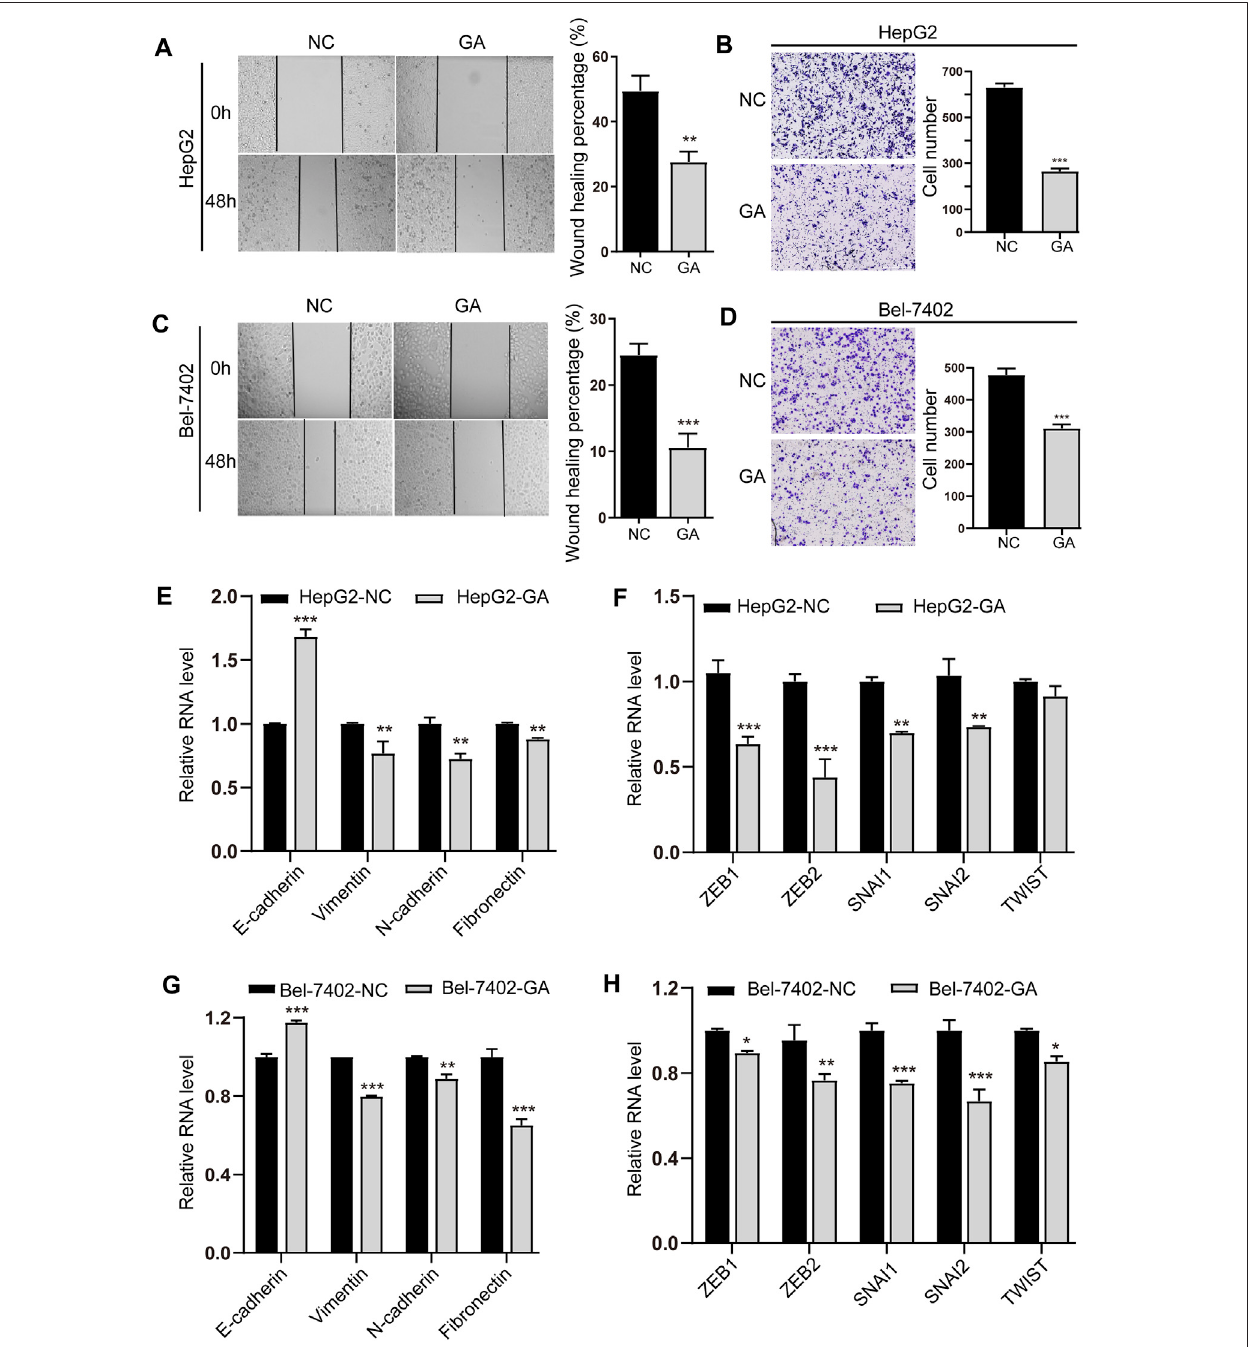
FIGURE 3 | GA inhibited the EMT and metastasis of HCC cells. HepG2 (A) and Bel-7402 (C) cells were treated with 80 μ M for 48 h, and wound-healing migration was assayed. The HepG2 (B) and Bel-7402 (D) cells treated with 80 μ M GA and invasion was examined. (E,G) The mRNA expression of E-cadherin, Vimentin, N-cadherin and Fibronectin in GA-treated HepG2 cells (E) and Bel-7402 cells (G) were measured by q-RT-PCR. (F,H) The mRNA expression of ZEB1, ZEB2, SNAI1, SNAI2,TWISTinGA-treatedHepG2cells (F) andBel-7402cells (H) weremeasuredbyq-RT-PCR.Dataarepresentedasmean ± SEM.*, p < 0.05;**, p < 0.01;***, p < 0.001; vs NC.